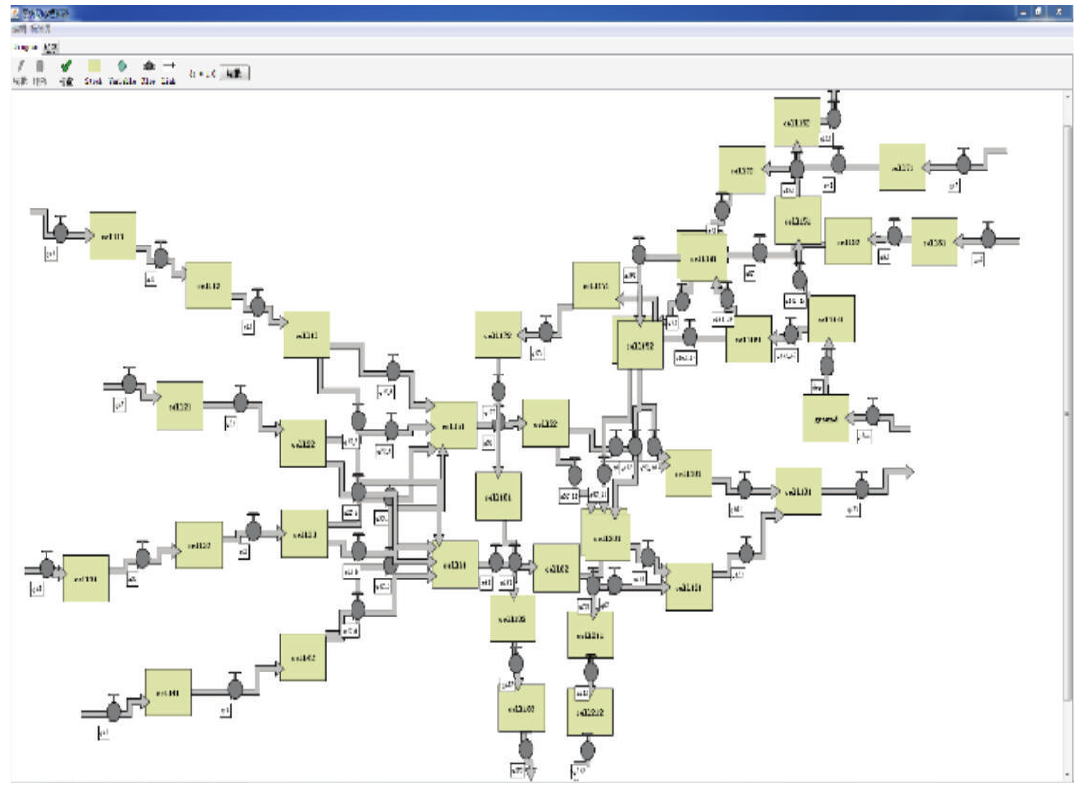
Figure 5: NetLogo system dynamic